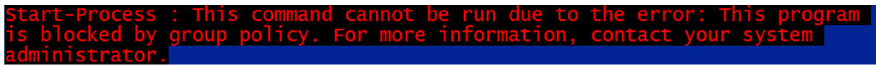
Fig 2. Attempt of payload execution from user profile Fig 1. Frameworks to manage PCs at CERN